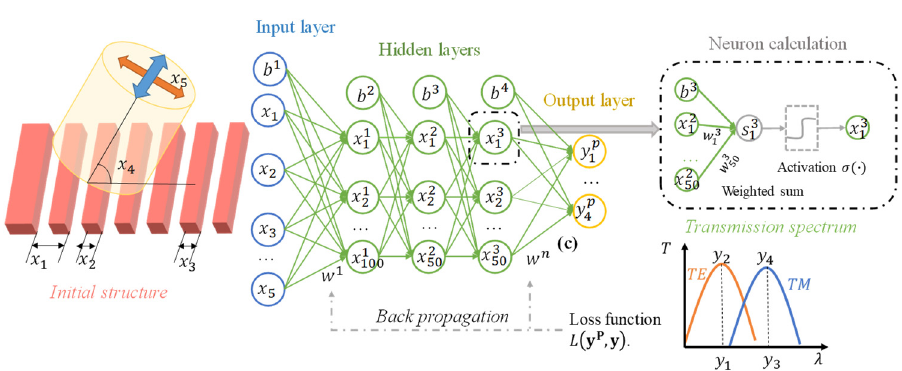
Figure 6. Training of an MLP to predict the coupling efficiency of grating couplers.